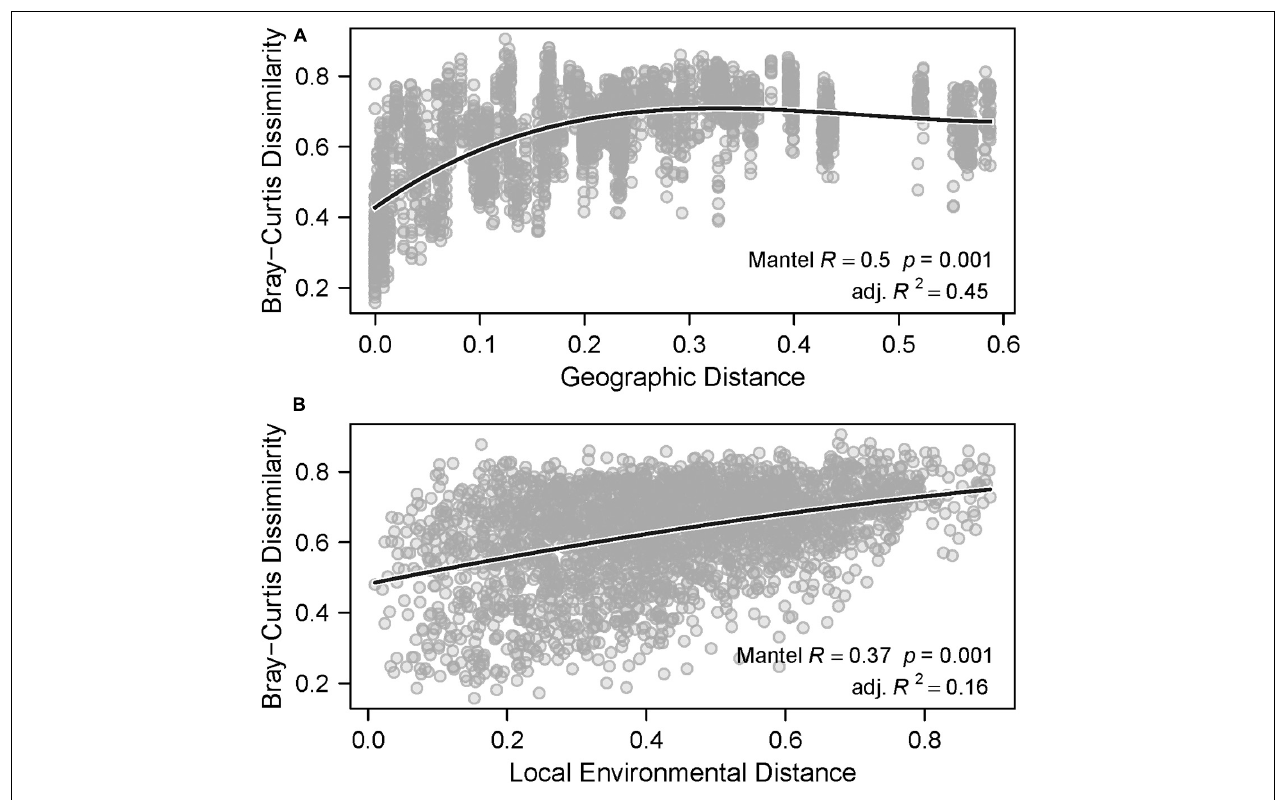
FIGURE 6 | Beta-diversity against (A) geographic distance and (B) local environmental distance. The solid lines represent the polynomial